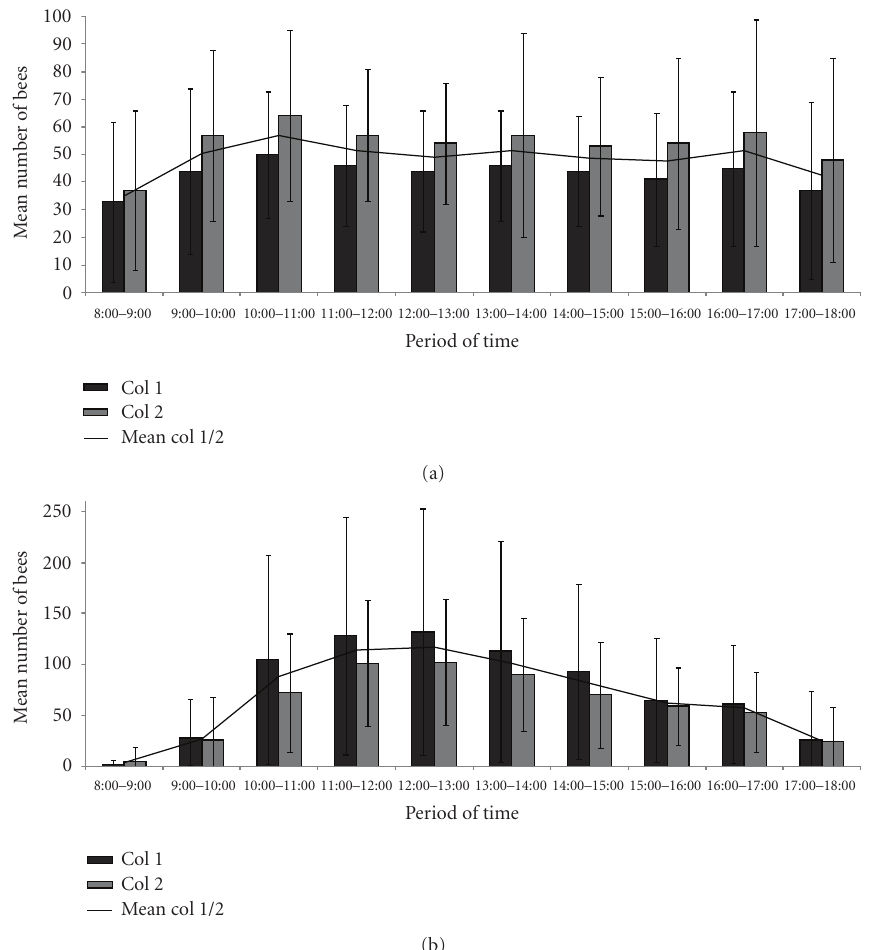
Figure 3: Nectar collection patterns of two colonies of Plebeia remota in the reproductive phase (a) and in the diapause (b).